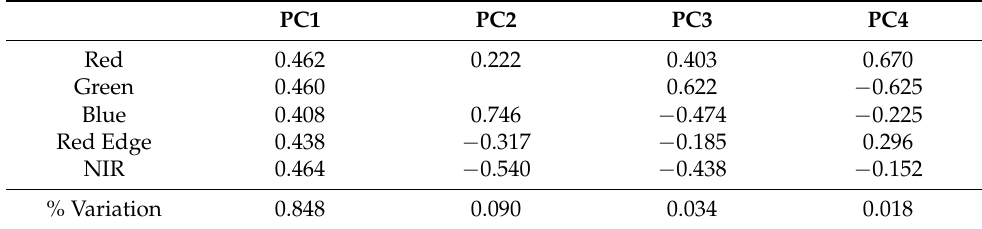
Table 3. PCA Loadings with Micasense